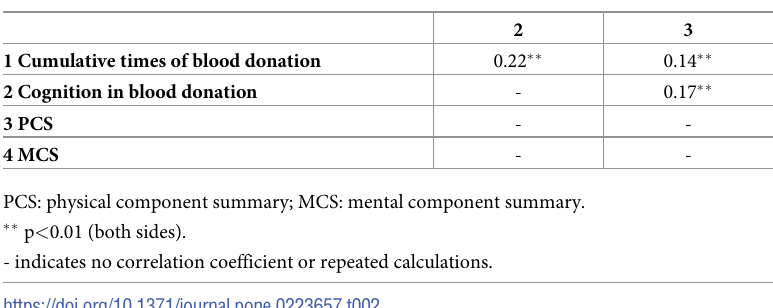
Table 2. Correlation matrix of model variables.